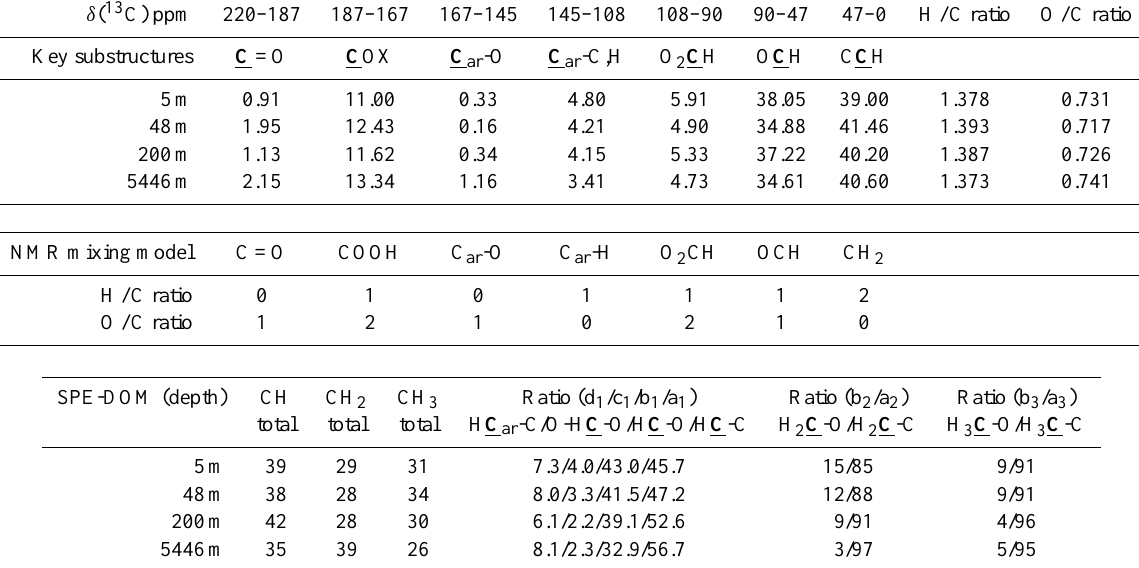
Table 3. Top: 13 CNMR section integrals (percent of total carbon) and key substructures of marine DOM. Middle: substructures used for NMR-derived reverse mixing model with nominal H/C and O/C ratios given. Bottom: percentage of methine, methylene and methyl carbon related to total protonated 13 CNMR integral as derived from 13 CDEPTNMR spectra of marine SPE-DOM according to carbon multiplicity (left 3 columns) and relative proportions of these CH n units binding to oxygen versus carbon chemical environments (cf. Figs. 8a and